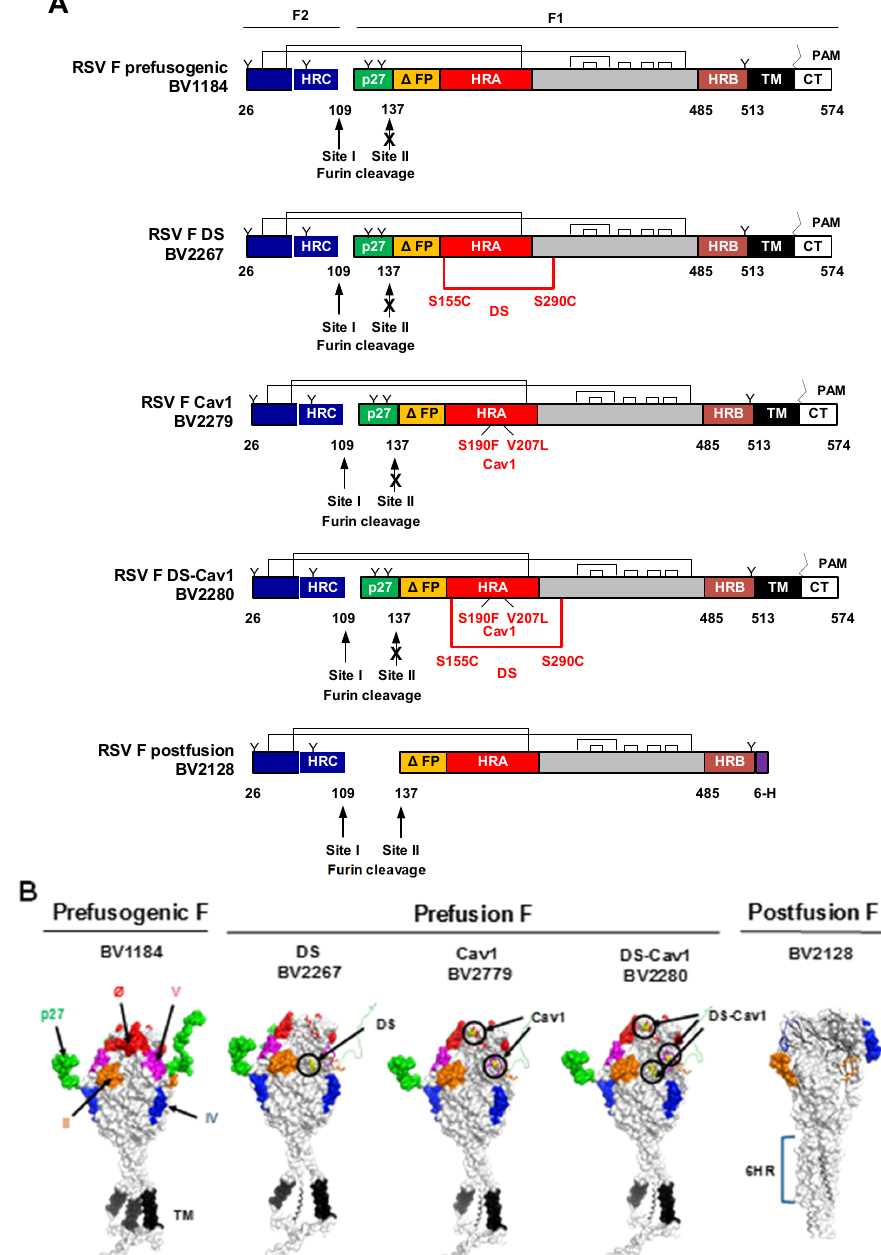
Figure 1. Respiratory syncytial virus fusion protein (RSV F) constructs used in this study. ( A ) Linear diagram of the RSV F glycoproteins constructed from the wild-type RSV / A2 fusion glycoprotein gene sequence (GenBank accession number MN125707). RSV F has two furin cleavage sites (arrows) that flank the intervening 27 amino acids (p27 fragment, green). To produce the prefusogenic RSV F (BV1184), furin cleavage site II was mutated (KKRKRR → KKQKQQ) to be protease resistant and is retained on the N-terminus of the F1 subunit. The first 10 amino acids of the adjacent fusion peptide were deleted ( Δ FP, yellow). The native native transmembrane (TM, black) and cytoplasmic tail (CT, white) were retained on the C-terminus of F1. The resulting F2 and F1 ectodomain is covalently coupled by two disulfide bonds (brackets). N -linked glycosylation sites are indicated by “Y”; palmitoleic acid (PAM) is indicated by “ ϟ ”; heptad repeats A, B, and C are indicated by HRA (red), HRB (brown) and HRC (blue). The prefusogenic F structure (BV1184) backbone was used to produce three prefusion F variants. RSV F DS (disulfide bond) variant (designated BV2267) was generated by introducing a stabilizing disulfide bond at positions S155C and S290C within the F1 subunit. RSV F Cav1 (BV2279) construct was generated by introducing two hydrophobic amino acids at positions S190F and V207L. The RSV F DS-Cav1 construct (BV2280) was generated with S155C/S290C disulfide bond and the S190F/V207L substitutions. Postfusion F (BV2128) was generated with intact furin cleavage sites I and II and truncation of the fusion peptide ( Δ FP, yellow). The TM and CT domains were deleted and replaced with a 6-histidine tag (6-H, purple). ( B ) Surface structures of the RSV F prefusogenic and prefusion trimers indicating key neutralizing antigenic sites antigenic sites Ø (red), V (pink), II (orange), and IV (blue), and the p27 fragment (green). The native transmembrane (TM, black) and cytoplasmic tail (CT, grey) are indicated. The RSV F postfusion 6-heptarepeat bundle (6HR) is indicated. 3.2. Antigenic Site-Specific Binding of mAbs to RSV F Proteins by ELISA A panel of human and murine mAbs targeting RSV F neutralizing sites was used to characterize the antigenic profile of the RSV F constructs. Using an ELISA method, prefusion-stable RSV F DS (BV2267), Cav1 (BV2279), DS-Cav1 (BV2280), and DS-Cav1-293 were bound by prefusion-specific mAbs D25 (site Ø) and hRSV90 (site V) at low antibody concentrations (EC 50 = 1.07–1.66 ng mL − 1 ), indicating neutralizing sites Ø and V were intact on these prefusion constructs. Prefusogenic F nanoparticles (BV1184) were also bound by mAbs D25 and hRSV90, although at higher antibody concentrations (EC 50 = 47.40 ng mL − 1 and 26.80 ng mL − 1 , respectively) suggesting these prefusion sites are present on prefusogenic F, although at lower levels (Figure 2A,B). Humanized palivizumab [9] and murine R1.42 mAbs [28] were used to detect antigenic sites II and IV, respectively. Prefusogenic F and prefusion F variants (DS, Cav1, DS-Cav1 and DS-Cav1-293) bound palivizumab (ED50 = 1.0– 3.0 ng mL − 1 ) and R1.42 (EC 50 = 2.4–6.1 ng mL − 1 ) at low antibody concentrations indicating sites II and IV were present on prefusogenic F and the prefusion F variants (Figure 2C,D). Prefusogenic F and prefusion DS, Cav1, and DS-Cav1 variants also bound mAb R7.10 at low concentrations (EC 50 = 2.7– 3.17 µg mL − 1 ) consistent with the p27 being preset on these F-trimers. DS-Cav1-293 bound R7.10 at a higher concentration (ED 50 = 22.1 µg mL − 1 ) compared to the other constructs, suggesting p27 may be less available to antibody binding (Figure 2E). All RSV F structures bound WHO RSV reference antibodies with comparable affinity (EC 50 = 1.12E-04 to 3.97E-04) (Figure 2F). These results indicate that antigenic sites Ø, V, II, IV, and p27 were present on prefusogenic F and the DS, Cav1, DS-Cav1 and DS-Cav-293 variants.